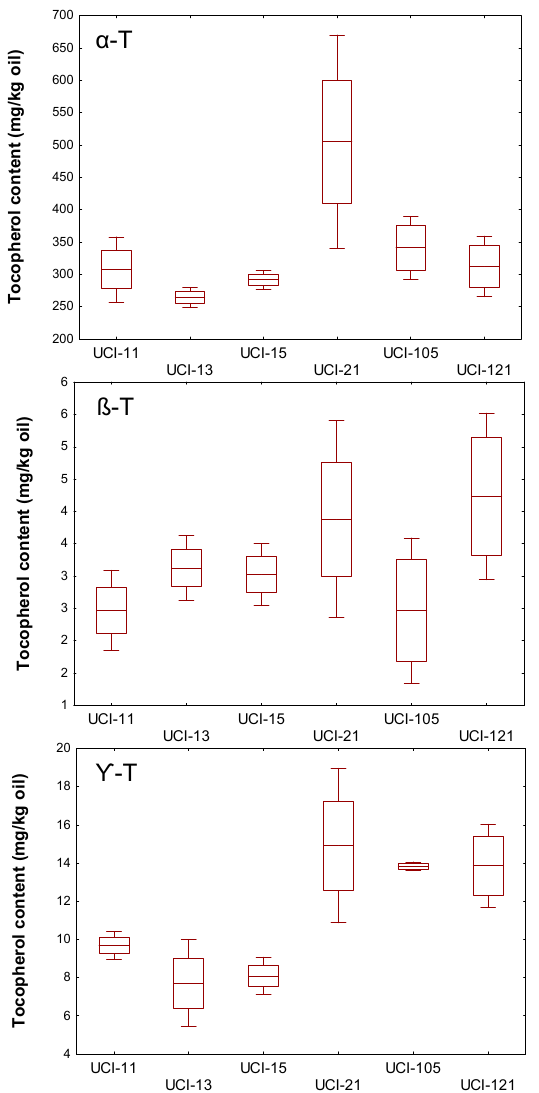
Figure 5. Variability across years for the contents (mg / kg oil) of the three forms of tocopherol in the oils from selected seedlings from the cross of ‘Picual’ and ‘Arbequina’: α -T, α -tocopherol; β -T, β -tocopherol; γ -T, γ -tocopherol. Horizontal inner lines in the boxes are mean values. The height in a box is equal to the standard error and the whiskers to standard deviation.